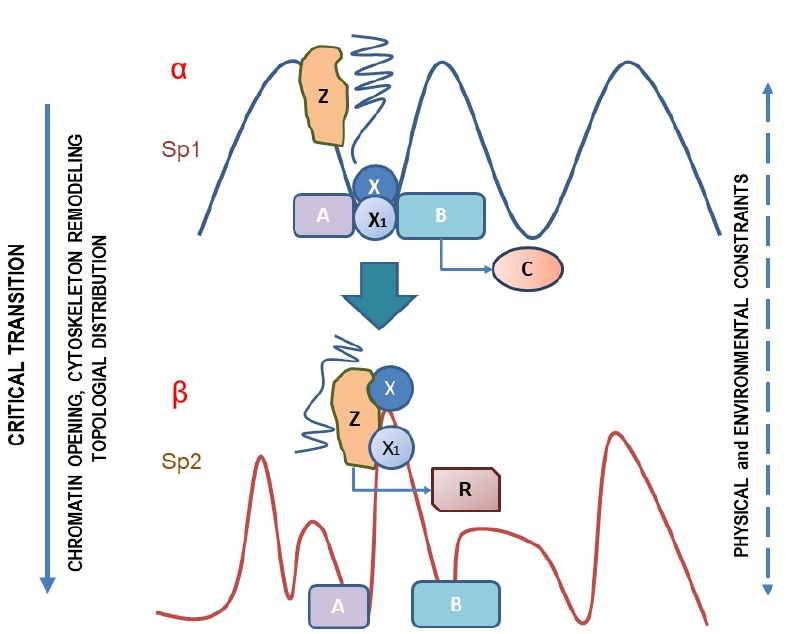
Figure 1. According to the hypothesis discussed in the text, the activation of the gene X, with subsequent synthesis of the correlated protein X1, is thought to interact with the substrates A and B, leading to the resulting product C. However, downstream of a phase transition the context cannot be considered constant anymore. When the system is undergoing a shift from the SP1 to the SP2 state, for instance the X1 gene product cannot physically interact with the native substrates A and B. Instead, the gene X can now establish a relationship with the substrate Z, leading to the appearance of the “new” product R. Ultimately, the activation of the same gene X triggers a novel pathways, absent in the previous phenotypic context, while the product C, released in the previous setting, is actually silenced. Ultimately, through this process, the activation of the very same gene can lead to the promotion of different and even opposite pathways.